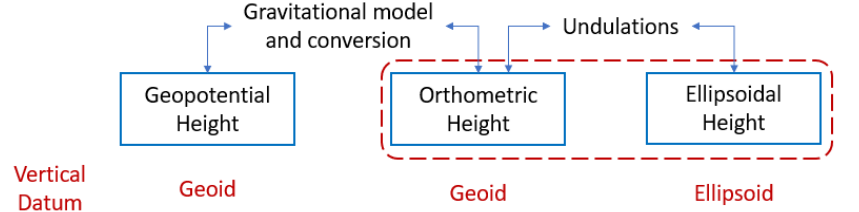
Figure 4. The transformation between geopotential altitude and ellipsoidal height is a non-linear process and depends on the underlying expressions used for the surface gravity on an ellipsoid and geoid undulations (which in turn depends on the geoid